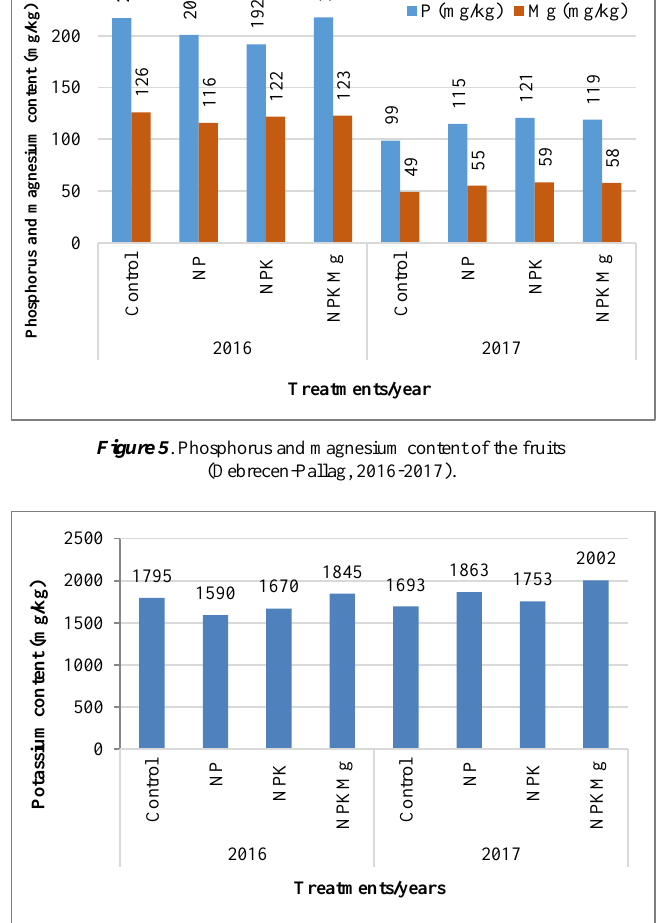
Figure 6. Potassium content of the fruits (Debrecen-Pallag,